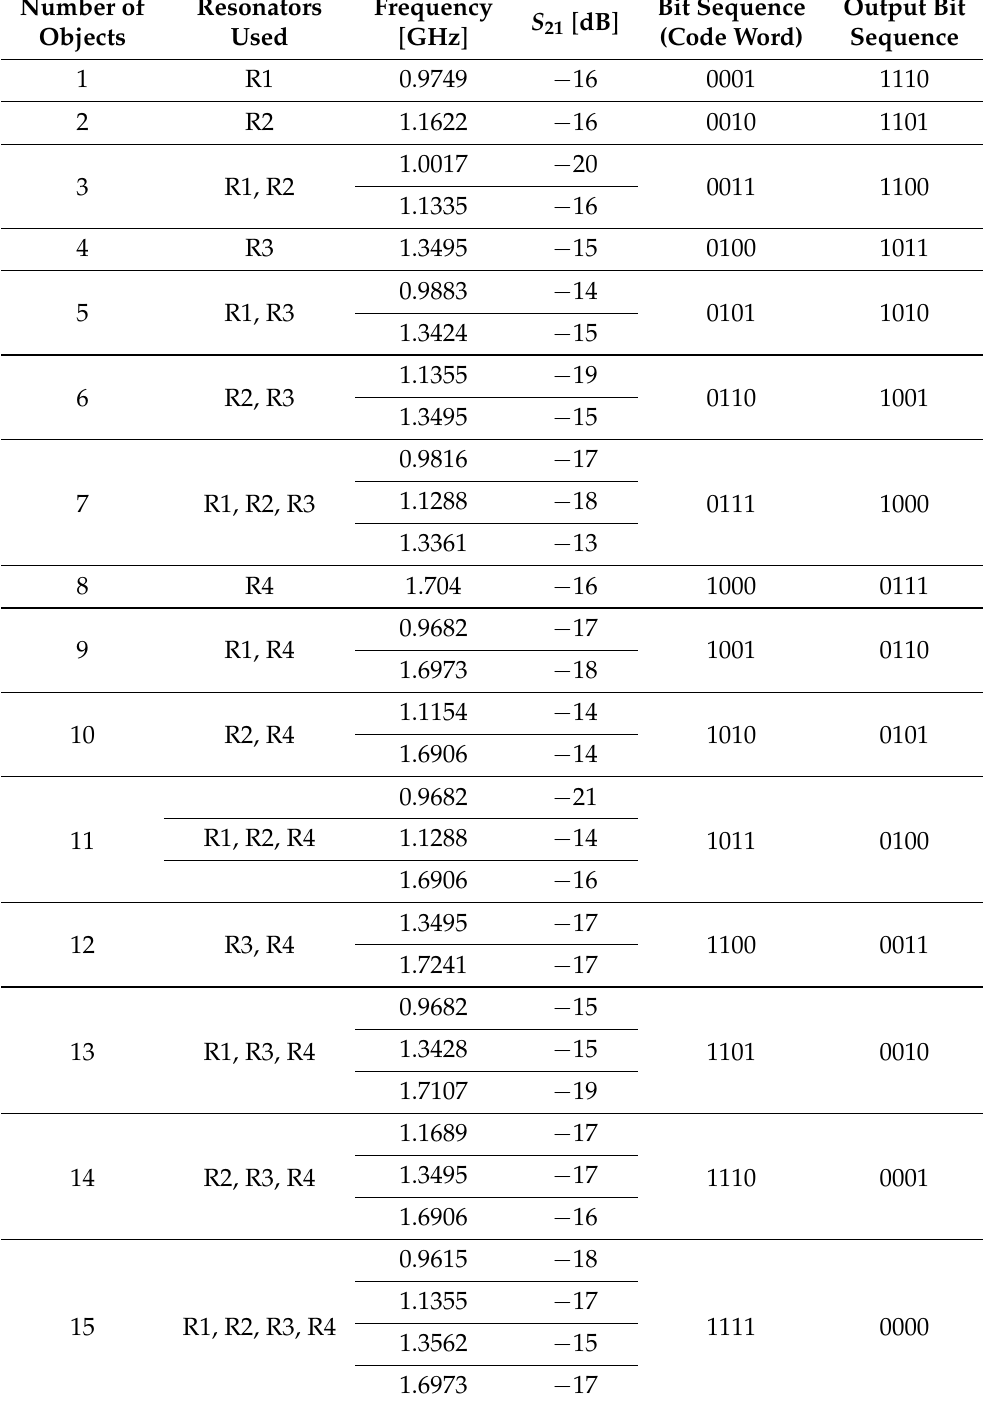
Table 2. Look up table for 4-bit CSR